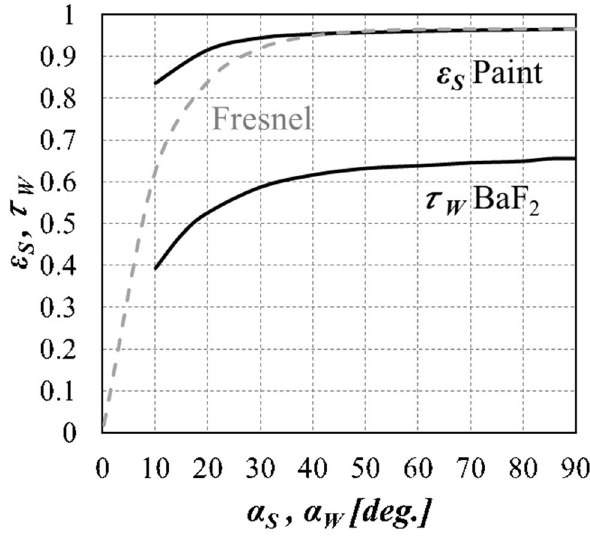
Fig. 5 Paint emissivity and window transmissivity as a function of observation